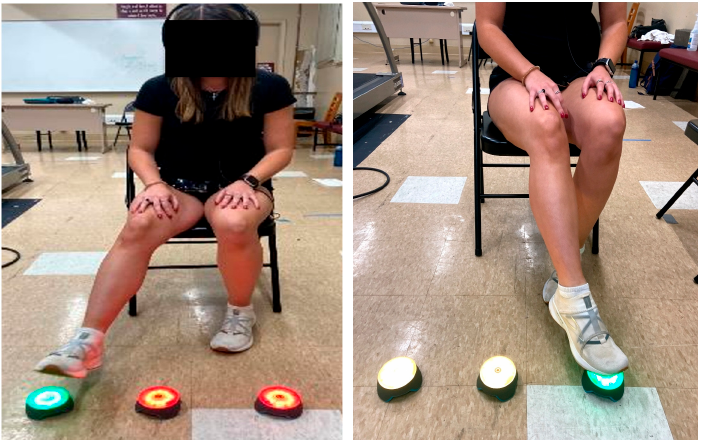
Figure 1. Participant performing a choice response time (CRT) task with noise interference delivered through headphones .